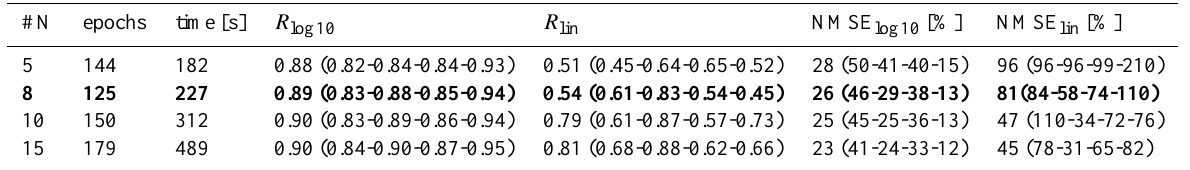
Table A4. Results of the sensitivity analysis on PhytoANN’s number of neurons in the hidden layer. Metrics are number of training iterations (epochs), training time, correlation coefficient and normalized mean-squared error on log-transformed and normal data. Presented statistics are ensemble means from five runs under the same configuration but different sample division and weight and bias initialization. Values in parentheses represent statistics for diatoms, coccolithophores, cyanobacteria and chlorophytes, respectively.